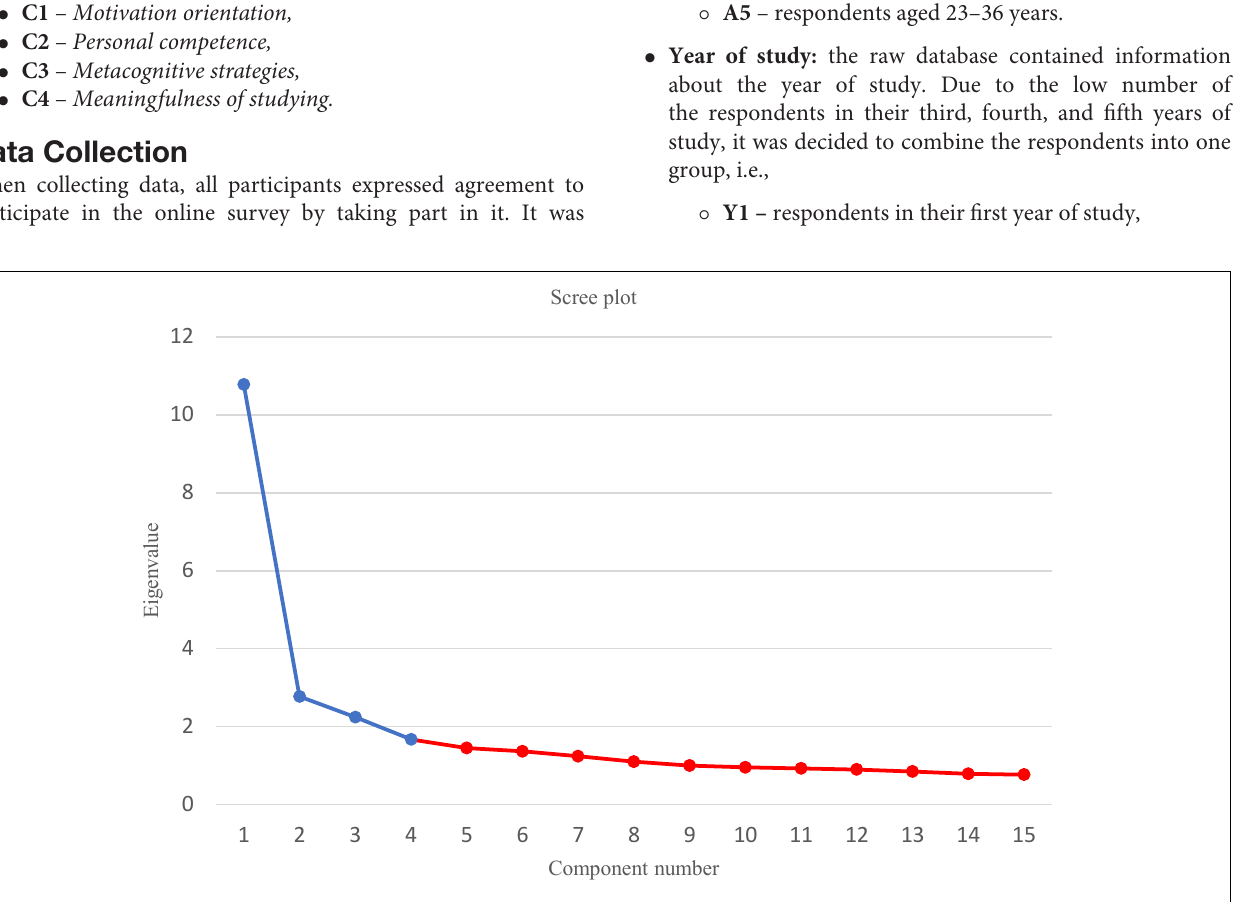
FIGURE 1 | Reduction of factors: Cattell criterion. The red part shows that “gentle” decrease begins and at what point the reduction to a higher number (5 and more) of factors is pointless.